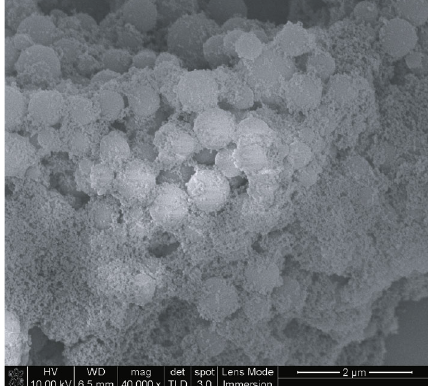
Figure 3: SEM image of the thin fi